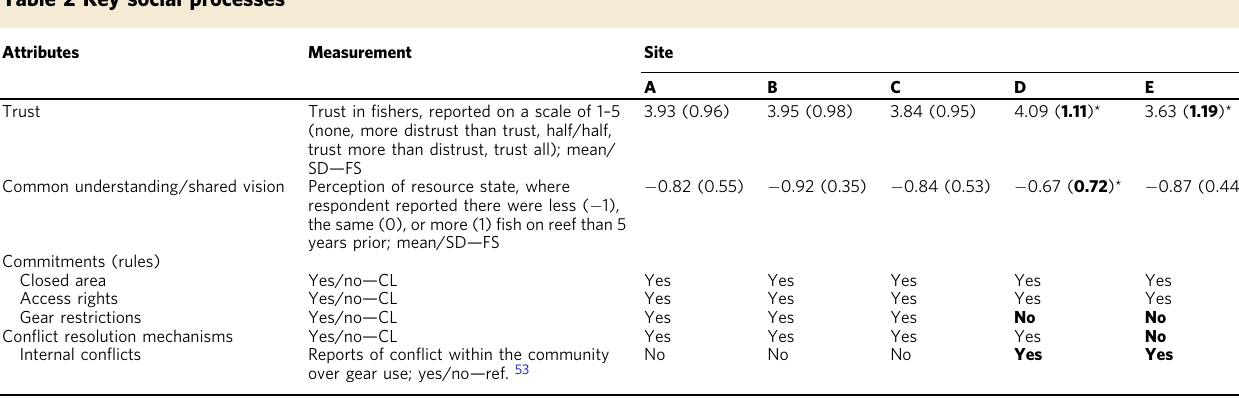
Table 2 Key social processes Attributes